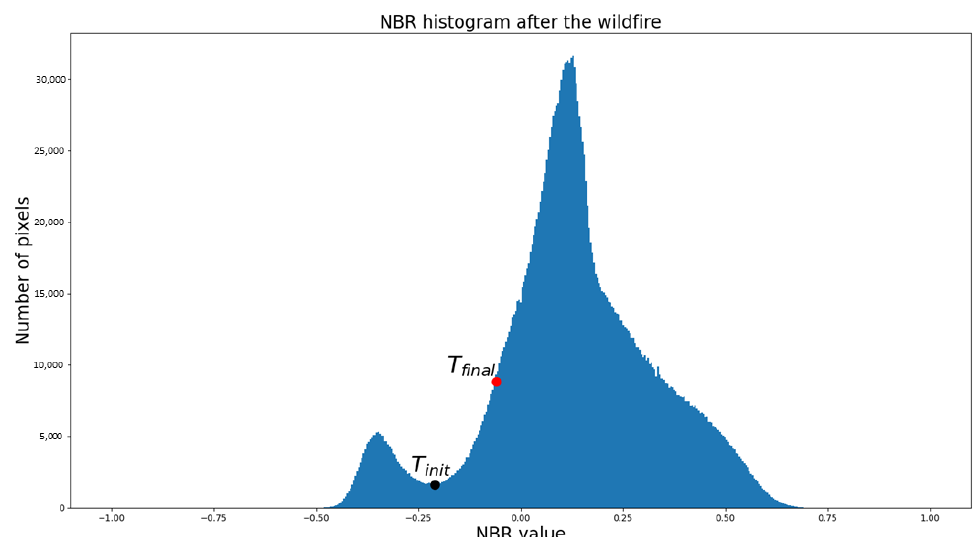
Figure 3. Histogram of the NBR index for the time instance after the fire. T init is the NBR index value that corresponds to the first valley of the histogram (dot in black color). T final is the threshold that is calculated after the adaptive segmentation method and will be used for the final separation of the pixels into burned and unburned classes (dot in red color).